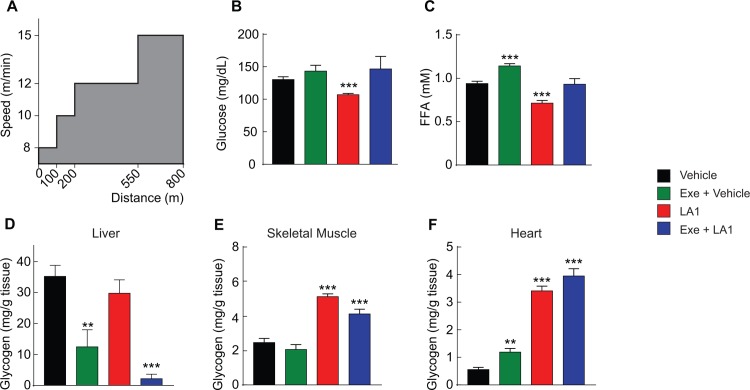
Effects of AMPK activators and exercise on glycogen accumulation and mobilization in liver, skeletal muscle, and heart.Lean mice, sedentary or exercised on treadmill, were treated with vehicle or LA1 (10 mg/kg, PO). (A) Exercise paradigm (n = 8). (B) Effects on plasma glucose. (C) Effects on plasma FFA. (D–F) Effects on glycogen contents of liver, skeletal muscle, and heart. *p < 0.05, **p < 0. 01, *** p < 0.001 relative to vehicle.